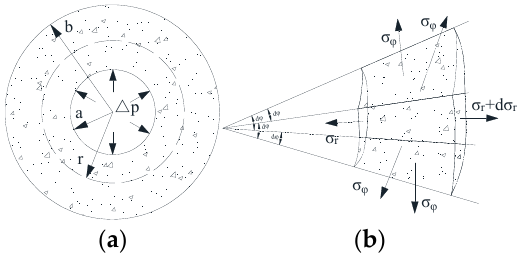
Figure 1. ( a ) Internal surface force diagram of pores; ( b ) Force balance diagram of micro element.